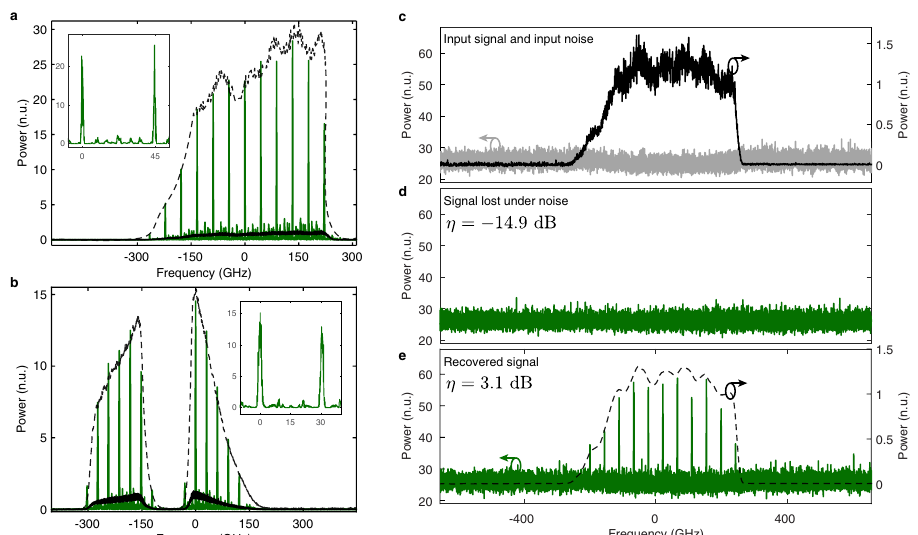
Fig. 2 S-TAI ampli fi cation and recovery of spectral waveforms. a , b The input waveform (black) is simultaneously ampli fi ed and sampled using the S-TAI (output shown in green). The input waveform scaled by the measured ampli fi cation factor is shown for comparison (dashed black trace). a The system was fi rst con fi gured for a high ampli fi cation factor of q = 32, with a peak separation ν = 44.8 GHz and a peak width ν = 1.4 GHz (see fi gure inset). The output q s waveform resulted in a measured ampli fi cation of 29.1 with ν q = 44.4 GHz, and ν s = 1.6 GHz. b To recover a more complicated waveform (i.e., with a longer duration), the temporal phase modulation signal was electronically recon fi gured for q = 15, allowing for a higher spectral resolution with a peak separation ν q = 30.1 GHz and a peak width ν s = 2.0 GHz. The output waveform resulted in a measured ampli fi cation of 14.43 with ν q = 30.3 GHz, and ν s = 2.2 GHz. c A weak optical waveform (black, right axis) is combined with strong stochastic (ASE) noise (gray, left axis). Notice the signi fi cant difference in the vertical scales. d The waveform is completely buried under noise, becoming undetectable. e Using the same parameters as those in Fig. 2a, the waveform of interest is successfully recovered from noise (green, left axis), as indicated by η , a measure of the visibility of the waveform against the noise, see Eq. (3). The input (dashed black trace, right axis) is shown for comparison, con fi rming that the envelope of the S-TAI peaks outlines an ampli fi ed, high- fi delity copy of the input signal. All shown optical spectra are represented as a function of the relative frequency with respect to a center optical frequency of 193.470 THz (wavelength of 1549.56 nm) on a linear scale normalized to the average power of the input coherent waveform measured at the locations of the output peaks (see “ Methods ”